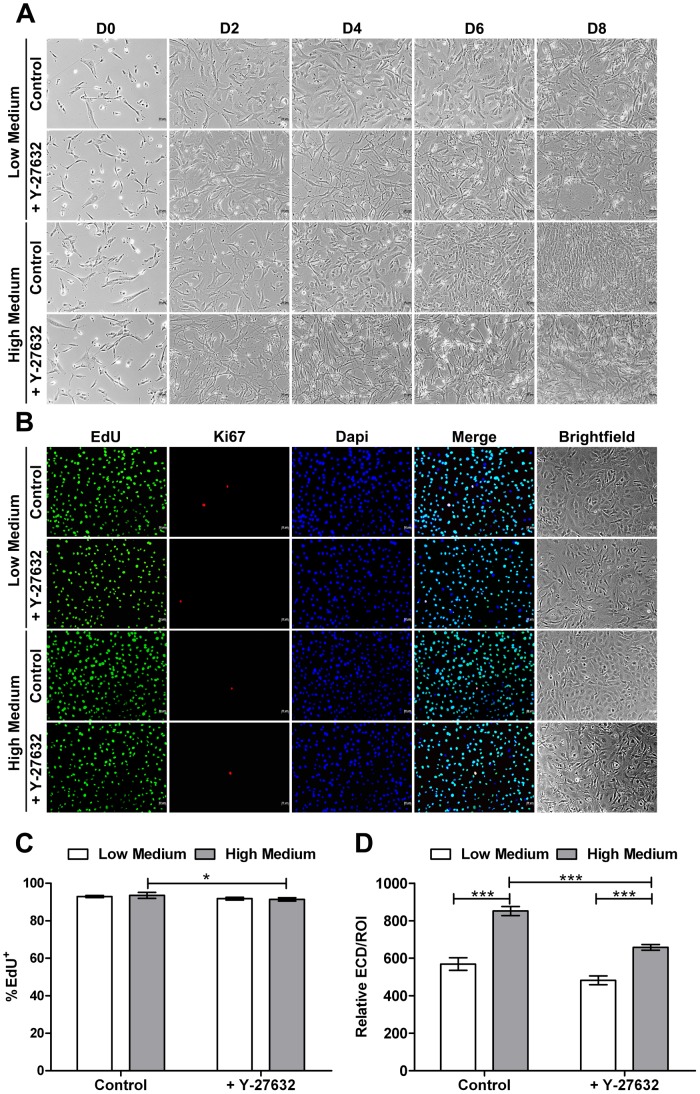

In vitro proliferation assessment.(A) Cell growth kinetic in Low or High Medium supplemented or not with Y-27632. Cells reach confluency more quickly in High Medium than in Low Medium. Cell shape in the two medium is different, with bigger cells and a more regular endothelial mosaic in Low Medium than in the High Medium where a poly and pleiomorphism are detected. Y-27632 addition induces modifications in cell proliferative potential and morphology. In both mediums, cells adopt a fibroblastic-like appearance. Additional time is necessary for cells to reach the confluency in the presence of Y-27632 whatever the medium. (B) Proliferation evaluation by EdU incorporation and Ki67 immunostaining. EdU and few Ki67 positive cells are detected in both groups. Magnification 10x. (C) Proliferation rate (%) corresponding to the number of positive EdU nuclei out of the total number of nuclei (EdU+Dapi nuclei). Globally no differences are noted between all groups, a light statistically significant decreased in EdU positive cells is observed between control and treated cells incubated in High Medium. (D) ECD in High Medium is higher than in Low Medium condition as well in the untreated as treated groups. A decreased of the ECD is observed in cells incubated in Low (−15%) and High Medium (−22%) supplemented with Y-27632 compared to the controls. Values are means +/− SEM (n = 9). *P<0.05 and ***<0.0001 (Student’s t-test).